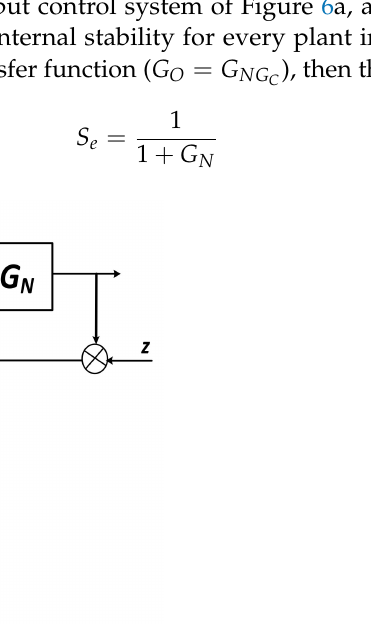
Figure 6. ( a ) Unity feedback plant with controller and ( b ) feedback loop in standard reduced